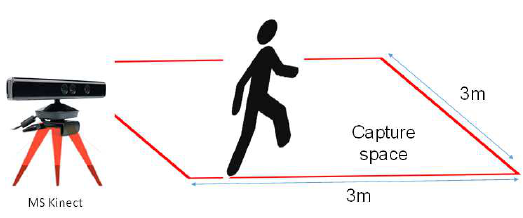
Fig. 9: Illustration of MS Kinect sensor v1 settings and data collection